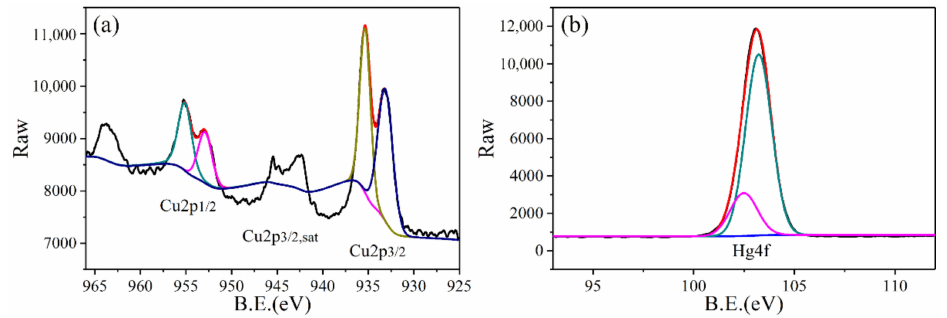
Figure 7. XPS fine spectrum for ( a ) Cu2p and ( b ) Hg4f of 2.5% CuCl 2